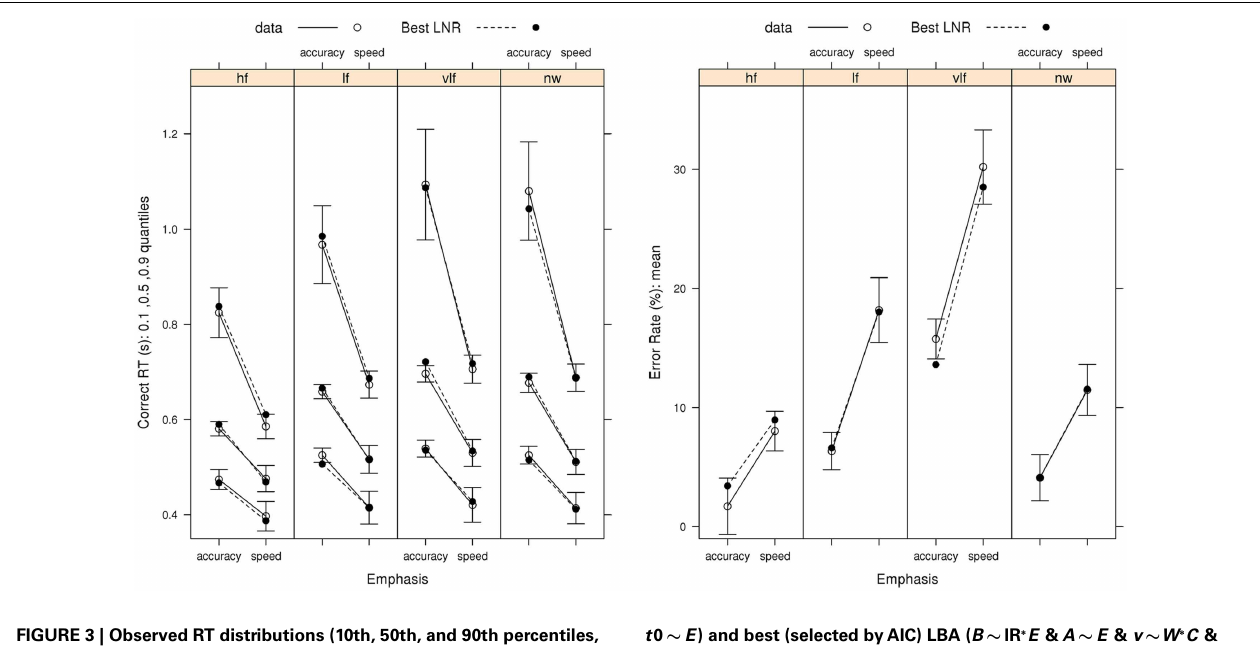
FIGURE 3 | Observed RT distributions (10th, 50th, and 90th percentiles, left column) and error rates (right column) forWagenmaker et al.’s (2008) Experiment 1 with bias-corrected within-subject 95% confidence intervals (Morey, 2008), and fits averaged over participants for the best (selected byAIC and BIC) LNR ( µ ∼ E ∗ W ∗ C & σ 2 ∼ E ∗ C &